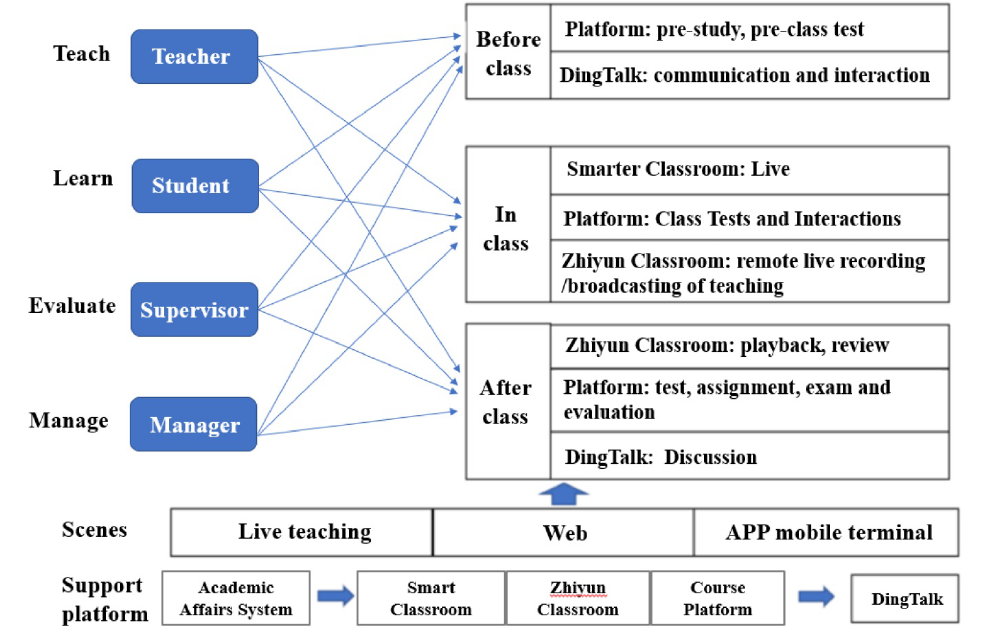
Fig. 5 Teach-Learn-Evaluate-Manage system